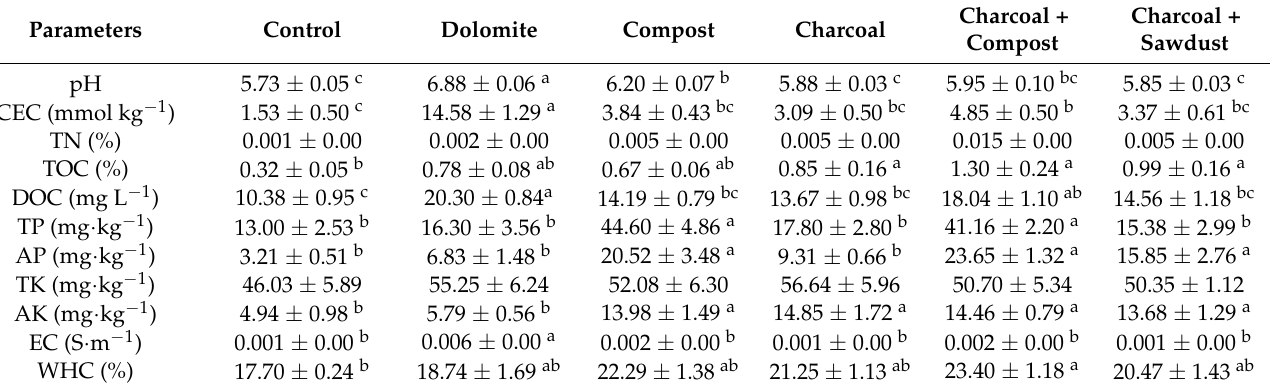
Table 6. Some physicochemical properties of the soils at harvest time. Cation exchange capacity, CEC; total nitrogen, TN; total organic carbon, TOC; dissolved organic carbon, DOC; total phosphate, TP; available phosphate, AP; total potassium, TK; available potassium, AK; and electrical conductivity, EC. Given are mean ± SE ( n = 4). Different letters indicate significant differences in treatment as revealed by one-way ANOVA followed by post hoc test at p <